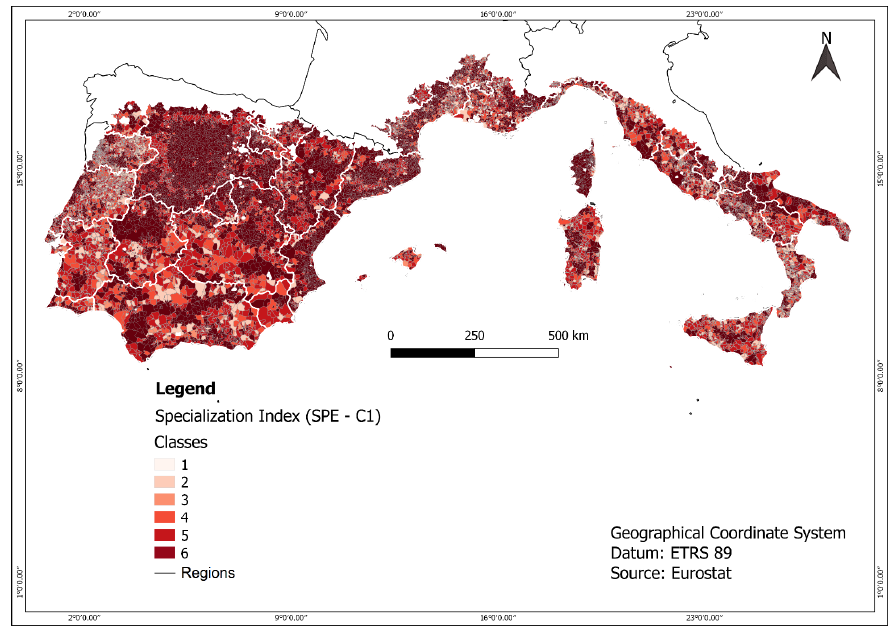
Figure 10. Map of spatial distribution of LAUs among the five intensity classes of SPE for the 1st census date (C1).